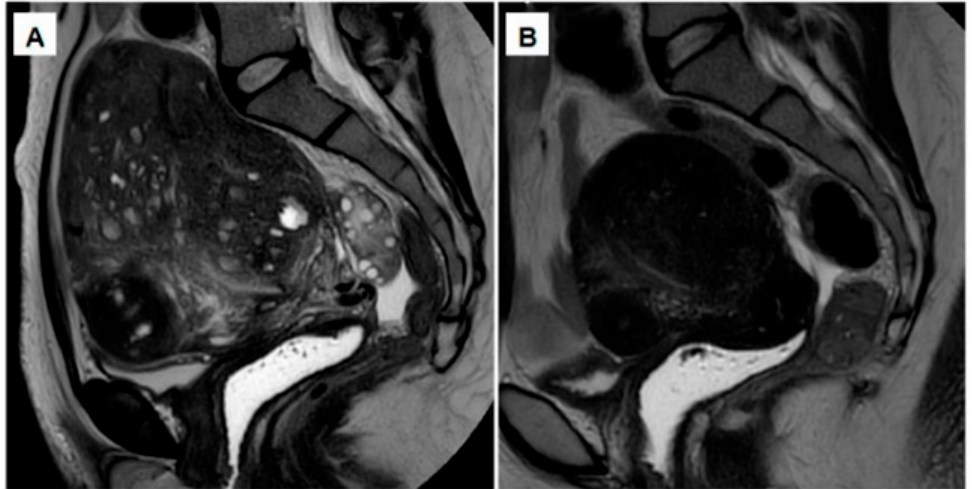
Figure 2. ( A ) MRI showing an enlarged uterus, consistent with severe full-thickness adenomyosis. ( B ) After a 12-week course of GnRH antagonist (200 mg linzagolix daily), a reduction can be observed in both uterine size and adenomyotic foci.